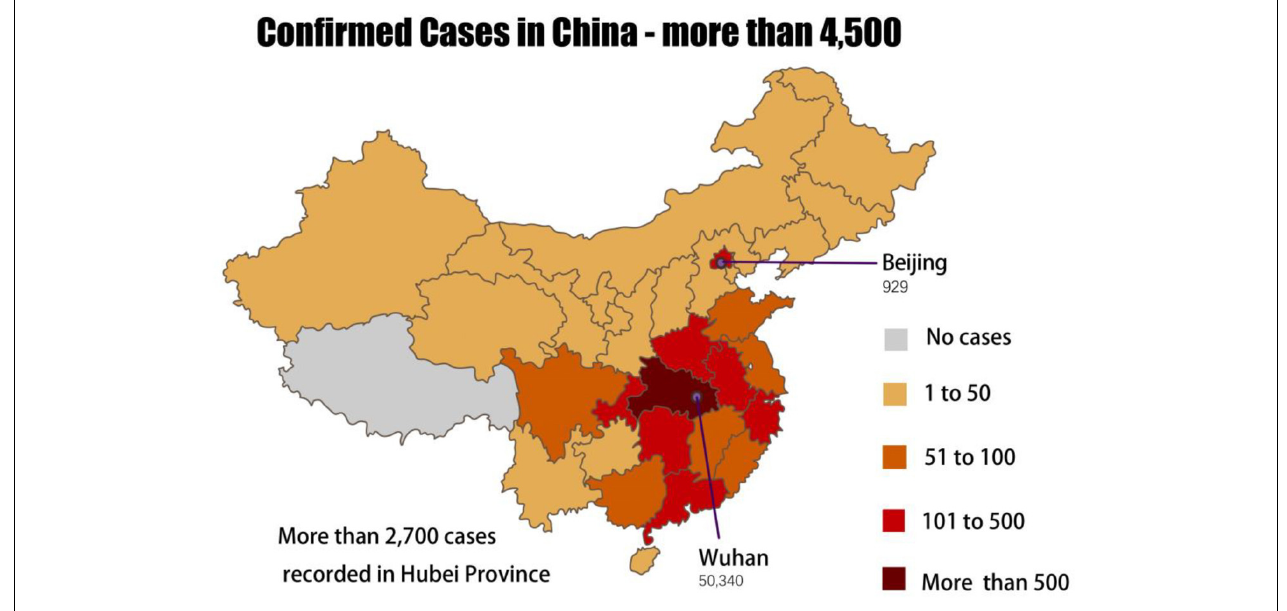
FIGURE 2 | Map showing the spread of the coronavirus in